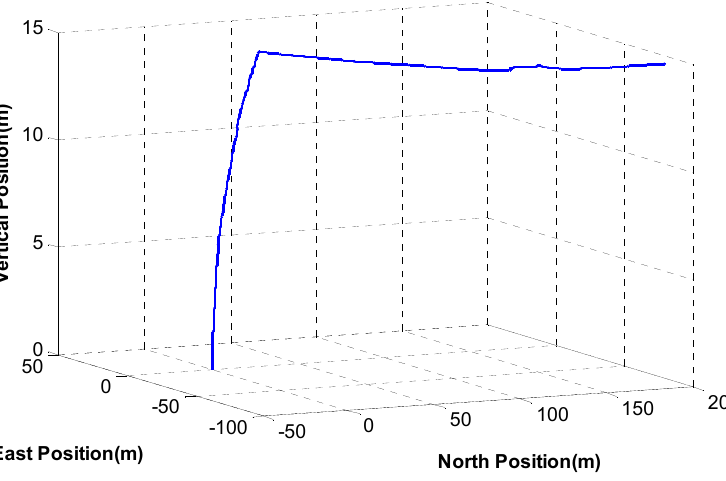
Figure 9. Three-dimensional flight trajectory.